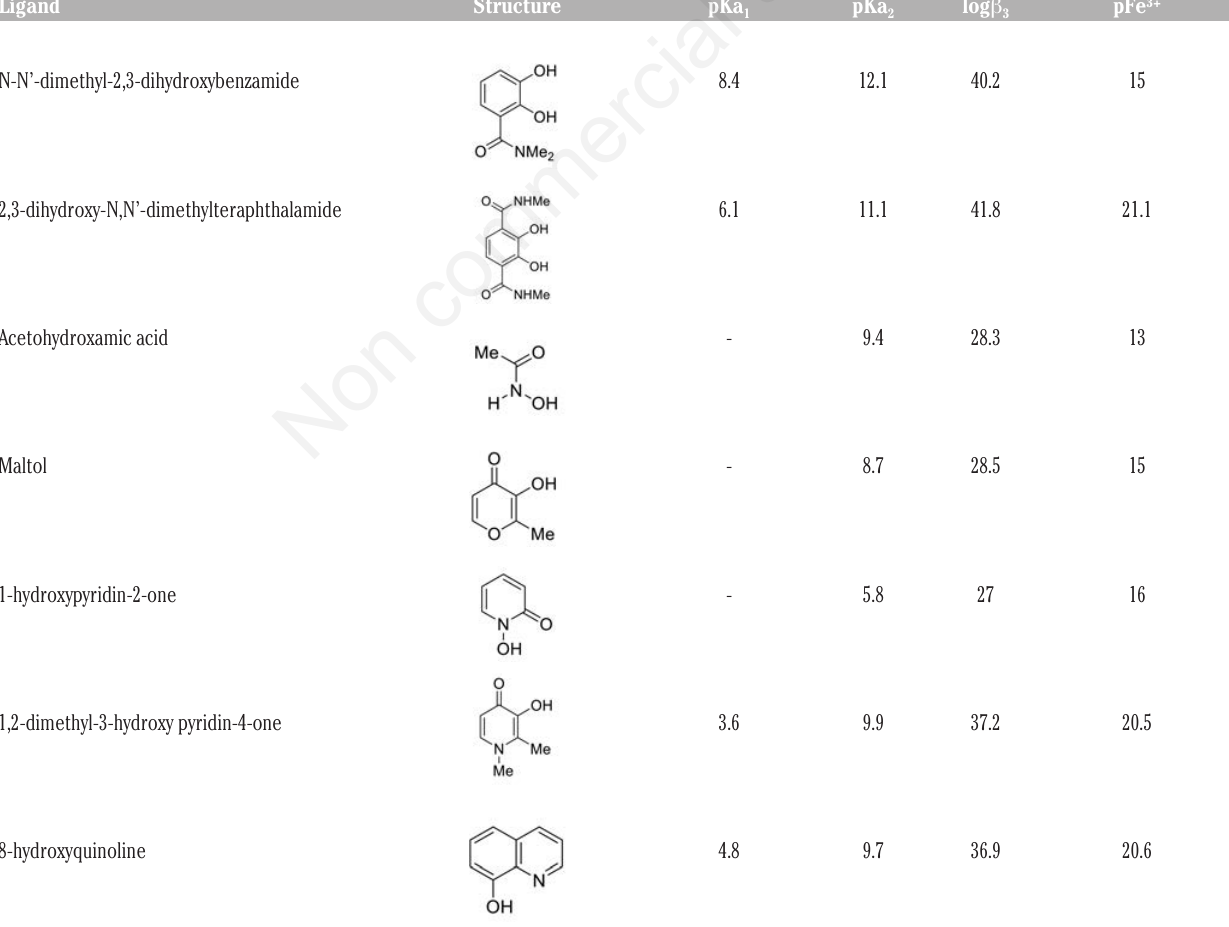
Table 1. pKa values and affinity constants for iron-binding bidentate ligands (data sourced from references: 54,56,90 ). Ligand